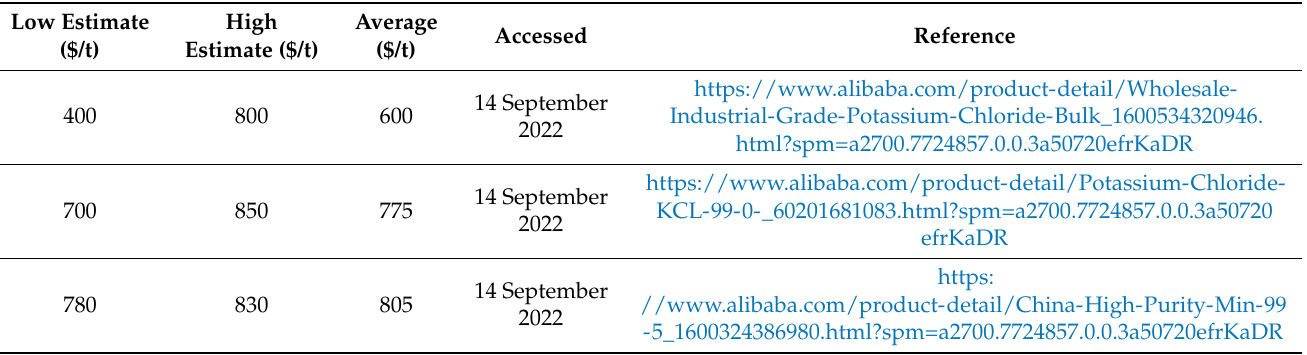
Table A3. Bulk Vendor Costs for KCl.